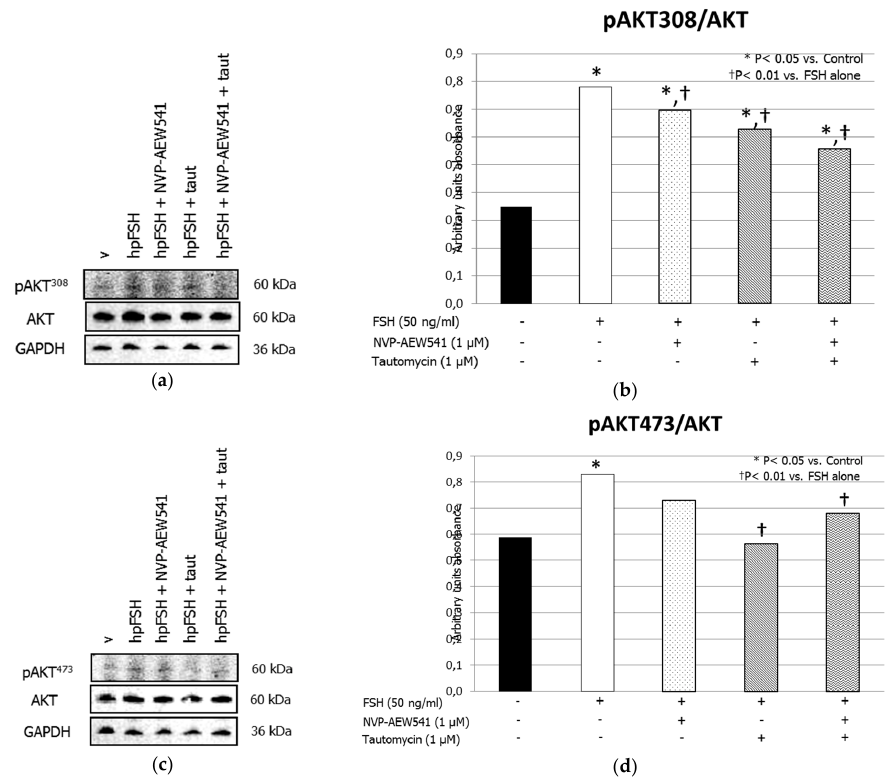
Figure 3. IGF1R is involved in the FSH-induced Protein kinase B (AKT) (Thr308) phosphorylation. ( a ) Immunoblots and ( b ) densitometric analysis of the protein bands of pAKT 308 , AKT and GADPH and ( c ) Immunoblots and ( d ) densitometric analysis of the protein bands of pAKT 473 , AKT and GADPH from SCs alone (control), or incubated with hpFSH alone or pre-treated with the IGF1R inhibitor NVP-AEW541 and / or PP1ß inhibitor tautomycin and then incubated with hpFSH. Data represent the mean ± SEM (* p < 0.05 vs. control and † p < 0.01 vs. FSH treatment alone) (one-way ANOVA) of three independent experiments, each performed in